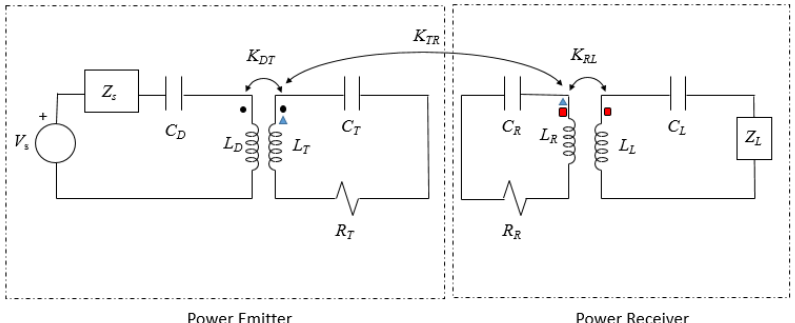
Figure 2. Common four-coil topology in SCMR circuits.